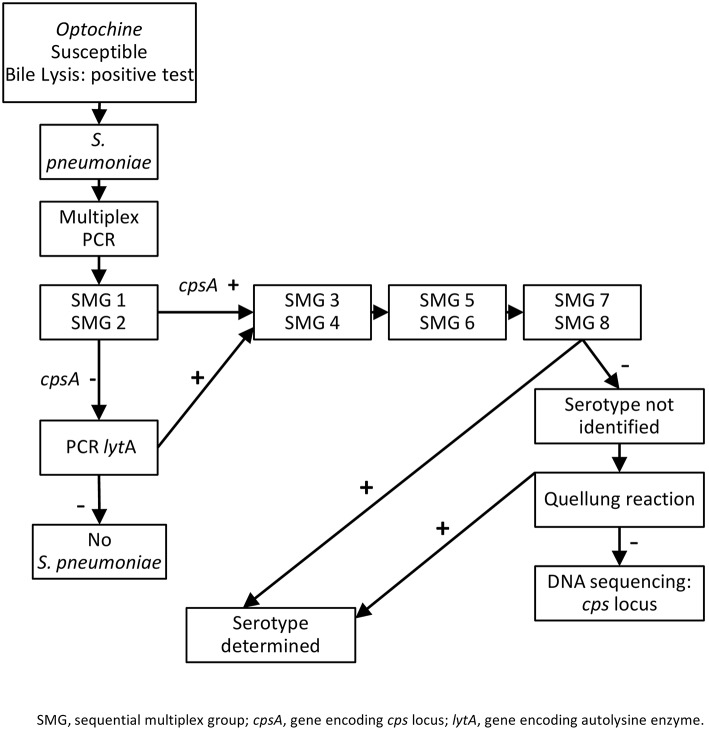
Multiplex PCR scheme used in capsular typing of S. pneumoniae isolates from Algeria, and general scheme proposed for usual pneumococcal serotyping.